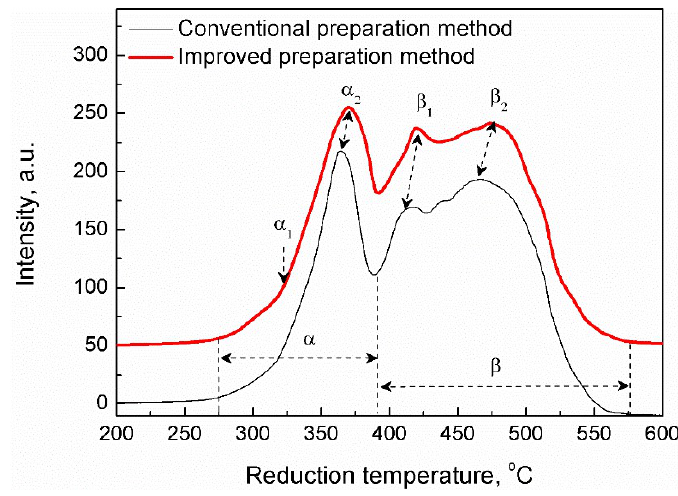
Figure 4. H 2 -TPR profiles of as-prepared Co/fumed SiO 2 catalysts using different approaches.